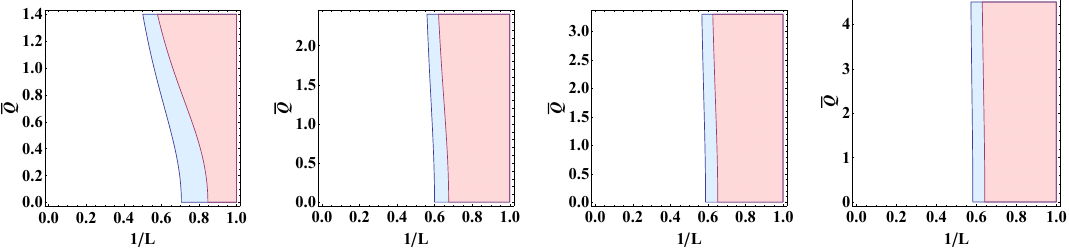
Figure 6 . The unstable region of the de Sitter charged Gauss-Bonnet black hole. From the left to the right (cid:11) = 1, 5, 10 and 20, respectively, where the light red region corresponds to ‘ = 3 and the light red region plus the light blue region correspond to ‘ =